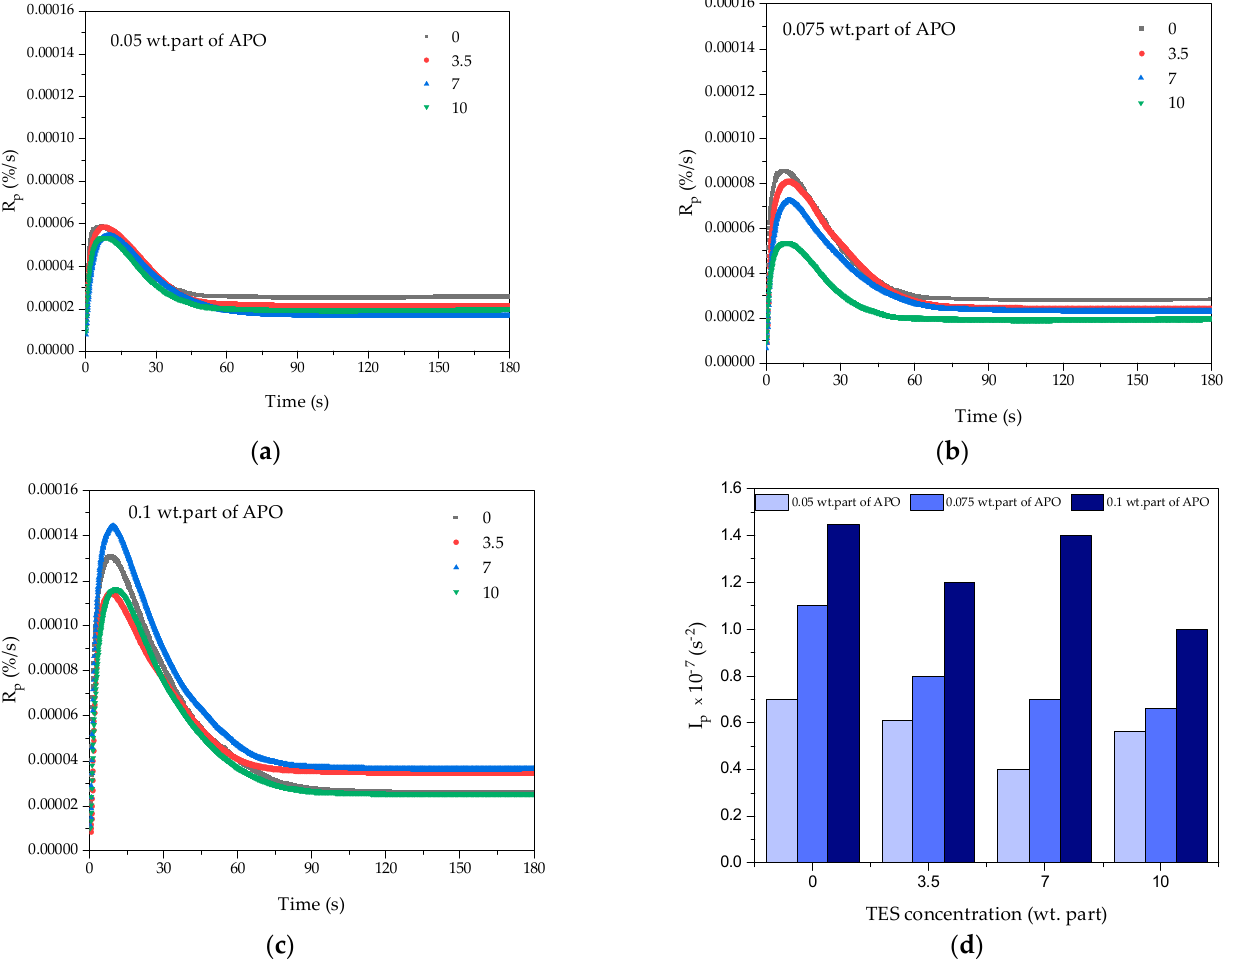
Figure 3. The kinetic curves recorded during UV telomerization of BA, AA, MMA, and ABP in the presence of TES as a telogen (0; 3.5, 7, or 10 wt. parts) initiated by ( a ) 0.05 wt. parts, ( b ) 0.07 wt. parts, and ( c ) 0.1 wt. parts APO and the photoinitiation index of the APO/TES systems ( d ).